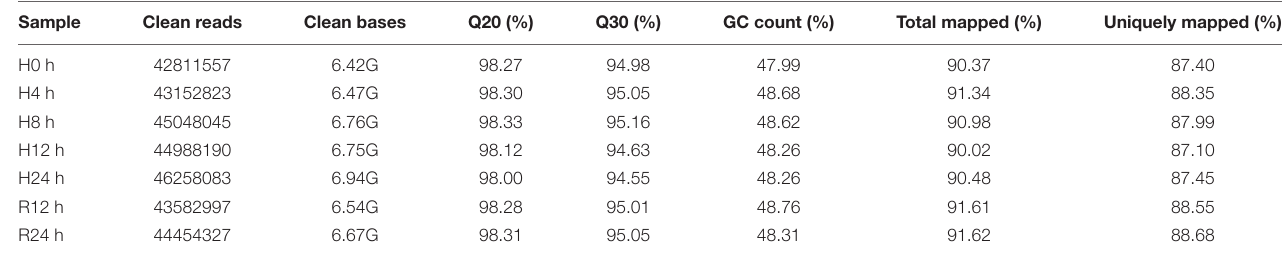
TABLE 2 | Illumina sequencing and mapping statistics of the gill transcriptomes of T. ovatus .